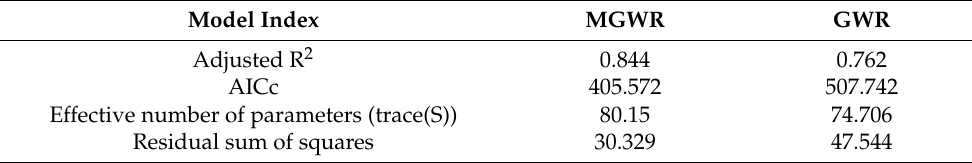
Table A1. Comparison of model indexes between MGWR and GWR.